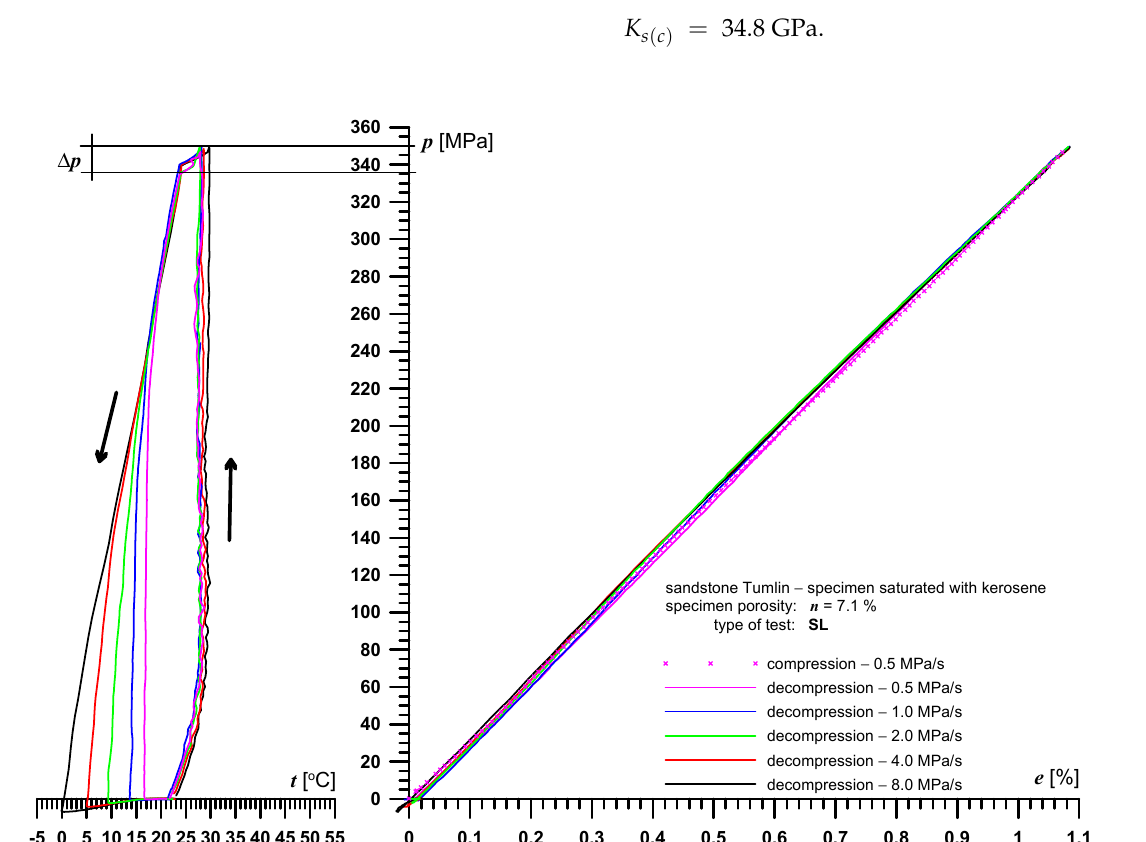
Figure 6. SL test result for Tumlin sandstone. Left : relationship between hydrostatic pressure and temperature (the arrows indicate the direction of change of hydrostatic pressure), right : relationship between hydrostatic pressure and volume change.